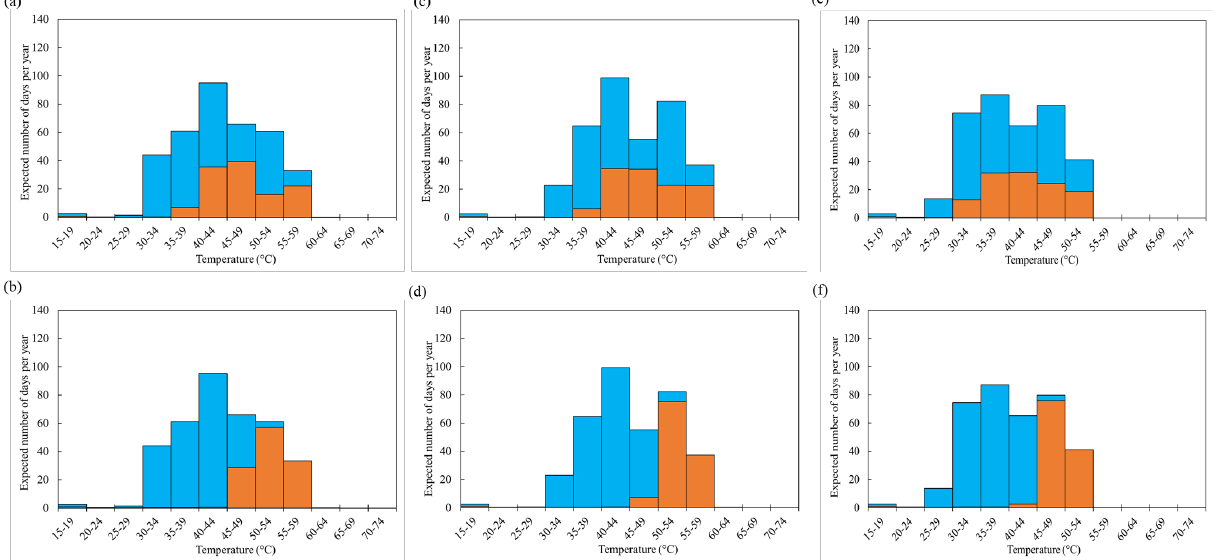
Figure 13. Correlation of influence factors at BRU location; ( a ) min saturation under B1, ( b ) max parameter setting under B1, ( c ) min saturation under FSL, ( d ) max parameter setting under FSL, ( e ) min saturation under LSS, ( f ) max parameter setting under LSS.